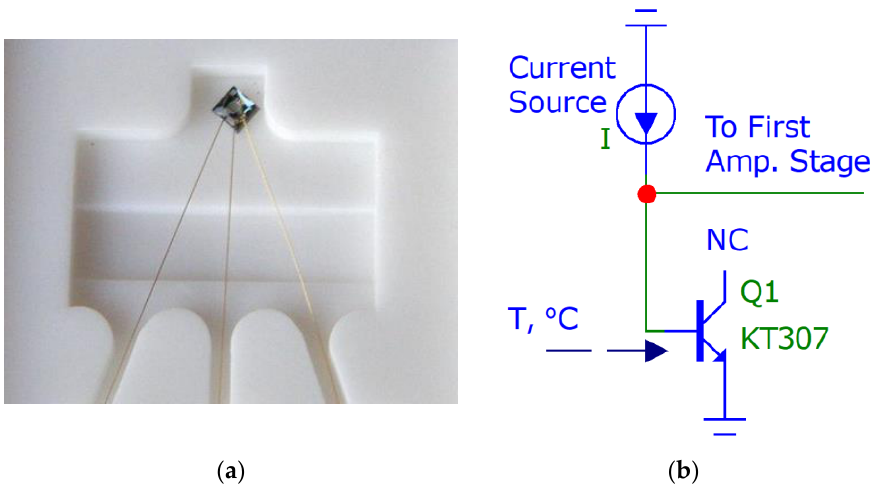
Figure 2. ( a ) Russian silicon chip transistor KT307 (size 0.7 × 0.7 × 0.1 mm, weight 2 mg); ( b ) connection of transistor to the current source and first amplification stage.